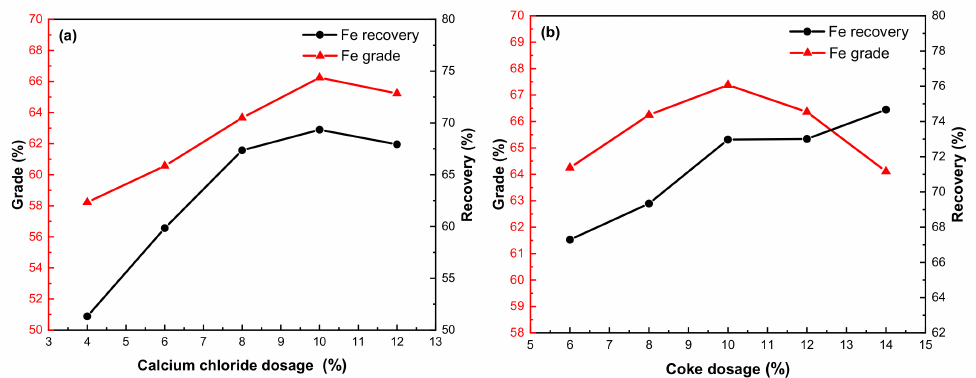
Figure 4. Effects of calcium chloride dosage ( a ) and coke dosage ( b ) on iron